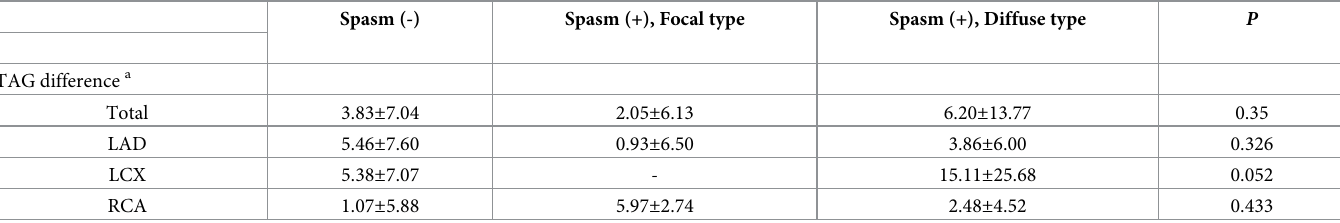
Table 5. Comparison of intra-subject differences in TAG values among normal, focal and diffuse spasm (+) vessels.